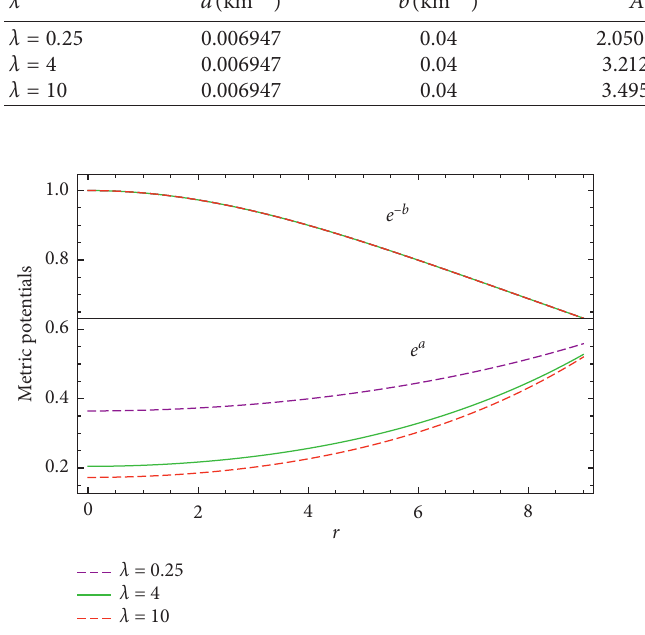
Table 1: The determined values of constants a, A , and B using data of compact star Vela X-1. Here, we choose λ � 0 . 25 , 4 , 10 and n � 7. λ a ( km − 2 ) b ( km − 2 ) A B ( km − 1 ) R ( km ) M / M λ � 0 . 25